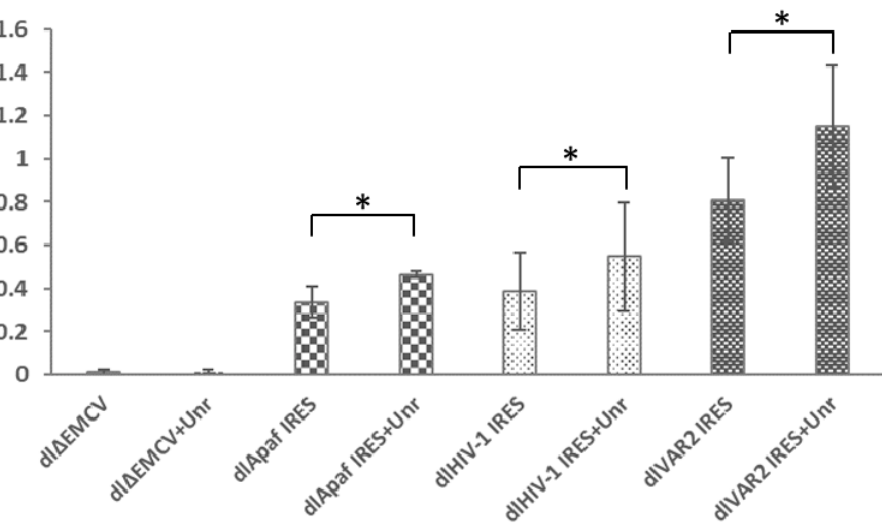
Figure 2. Effect of Unr overexpression on the activity of HIV-1 IRES. The IRES activity is monitored by the ratio of Fluc/Rluc luciferase activities in the dual luciferase assay. Two variants of HIV-1 IRES (HIV-1 and VAR2) are tested. The ∆ EMCV and Apaf-1 IRESs are given as negative and positive controls, respectively. Measurements were performed in HeLa cells 24 h post transfection. Histograms represent the mean ± SEM of at least 3 independent experiments done in triplicate. * p < 0.05.